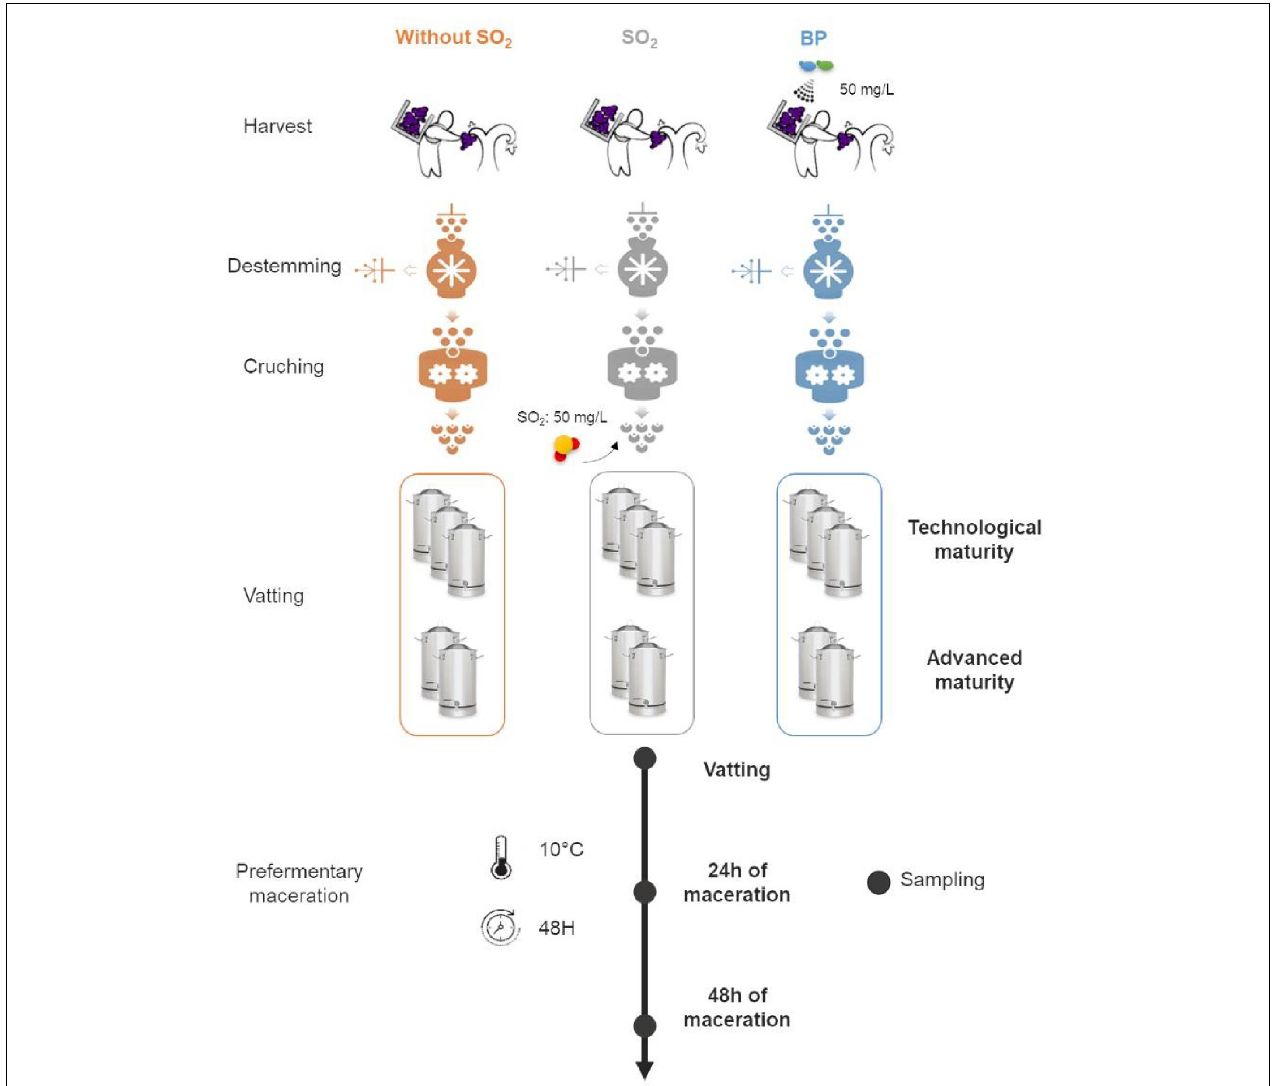
FIGURE 1 | Experimental design of the